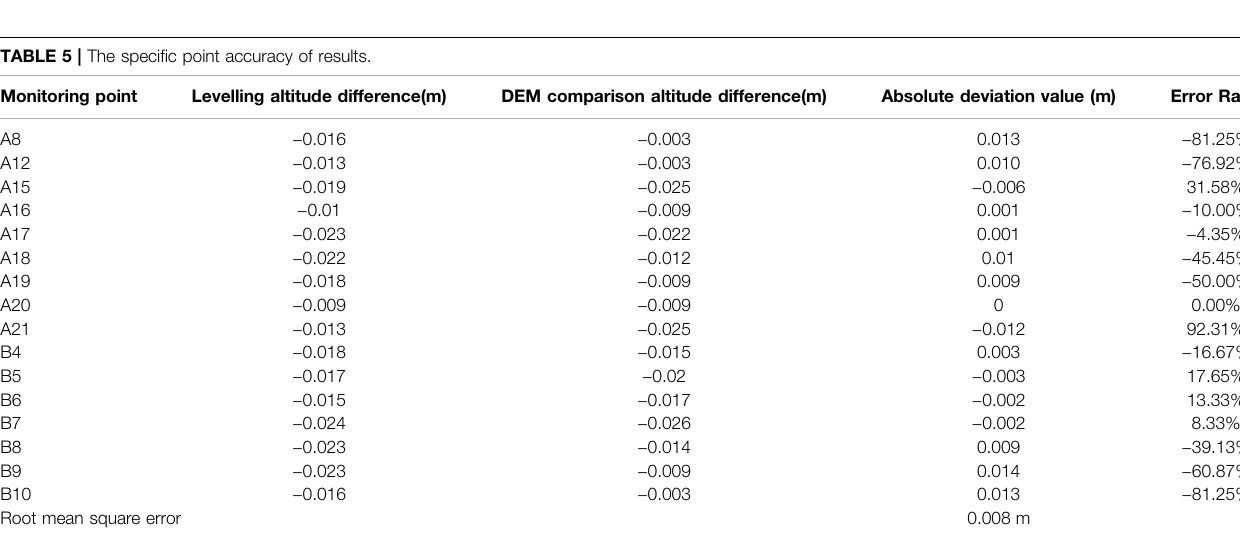
TABLE 5 | The speci fi c point accuracy of